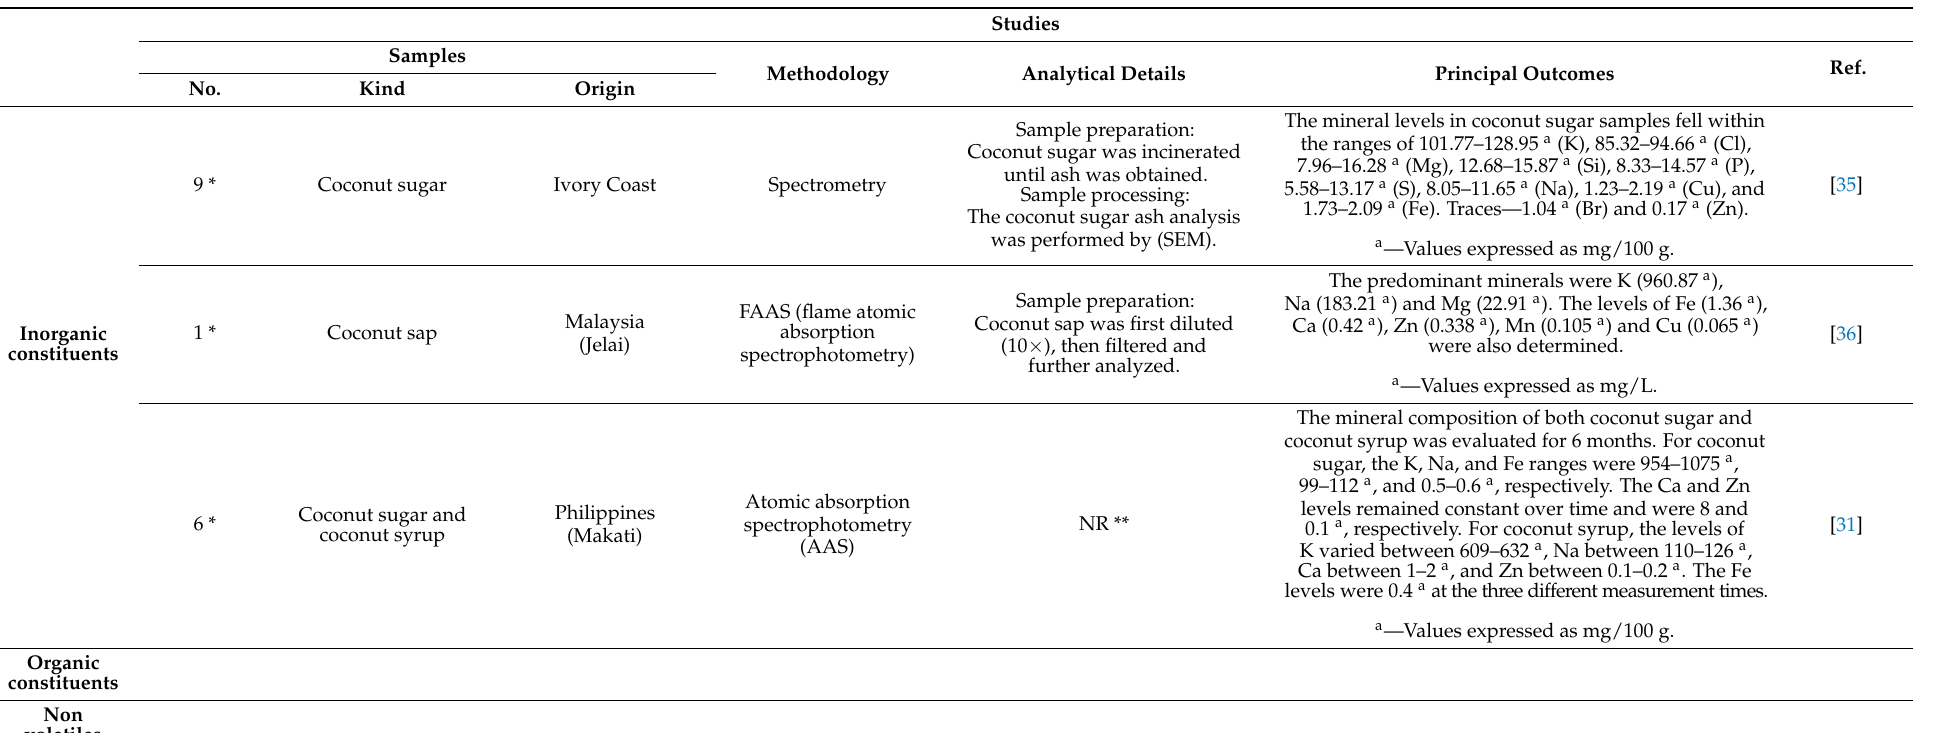
Table 2. Chemical analyses of the organic and inorganic constituents of coconut sap, sugar, and